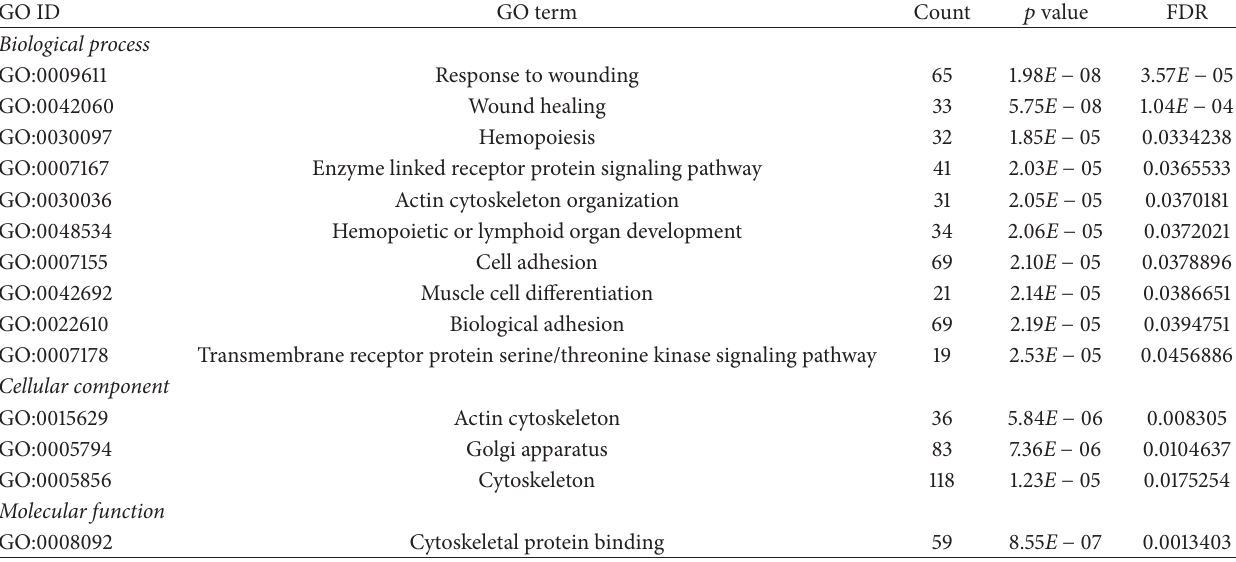
Table 4: GO annotation of downregulated DEGs in